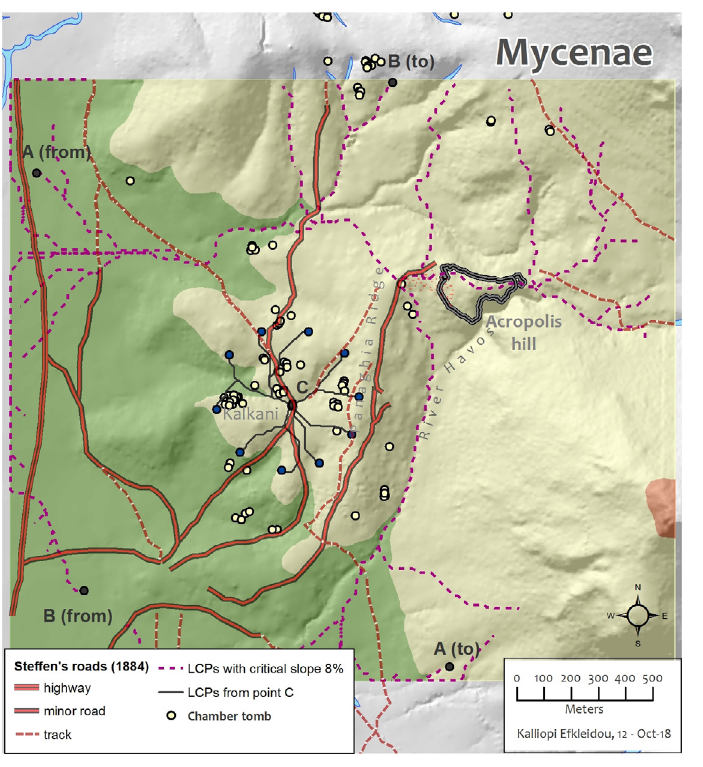
Figure 12. The LCPs based on an 8% critical slope raster originating from point C towards all directions, the 19th century road network and the chamber tombs west of the Panaghia ridge and the settlement of LBA